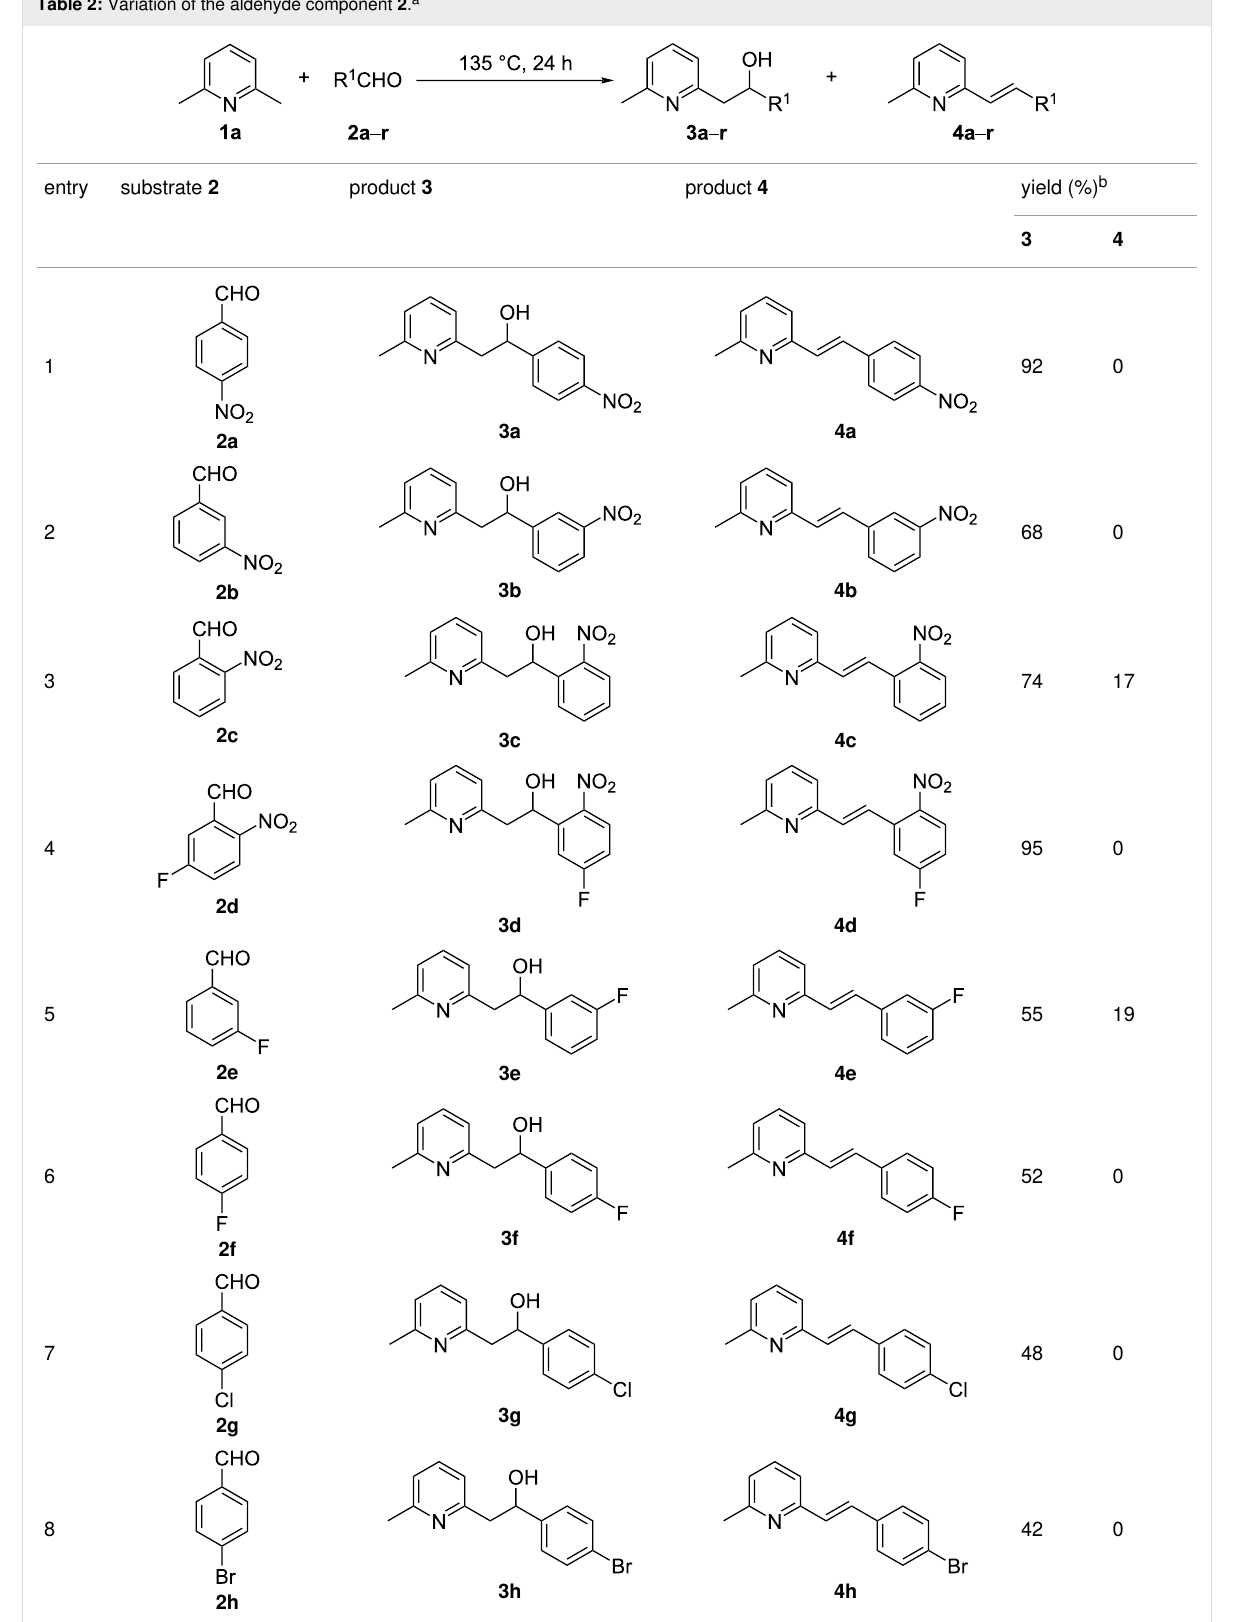
Table 2: Variation of the aldehyde component 2 .